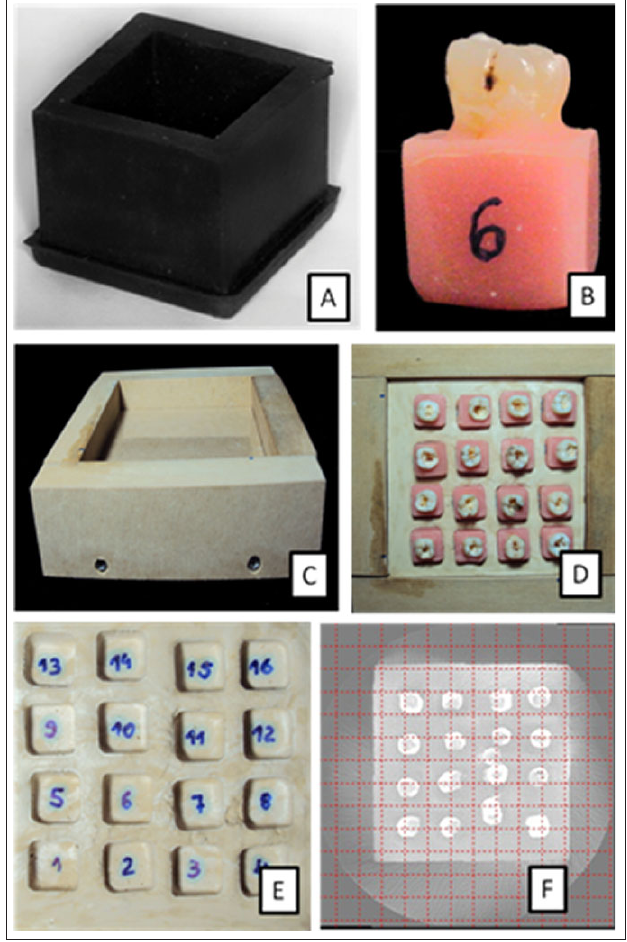
Fig.1. Sample preparation and imaging acquisition: A) Plastic cube; B) Specimen embedded in acrylic resin; C) Wood mould; D) Specimen embedded in